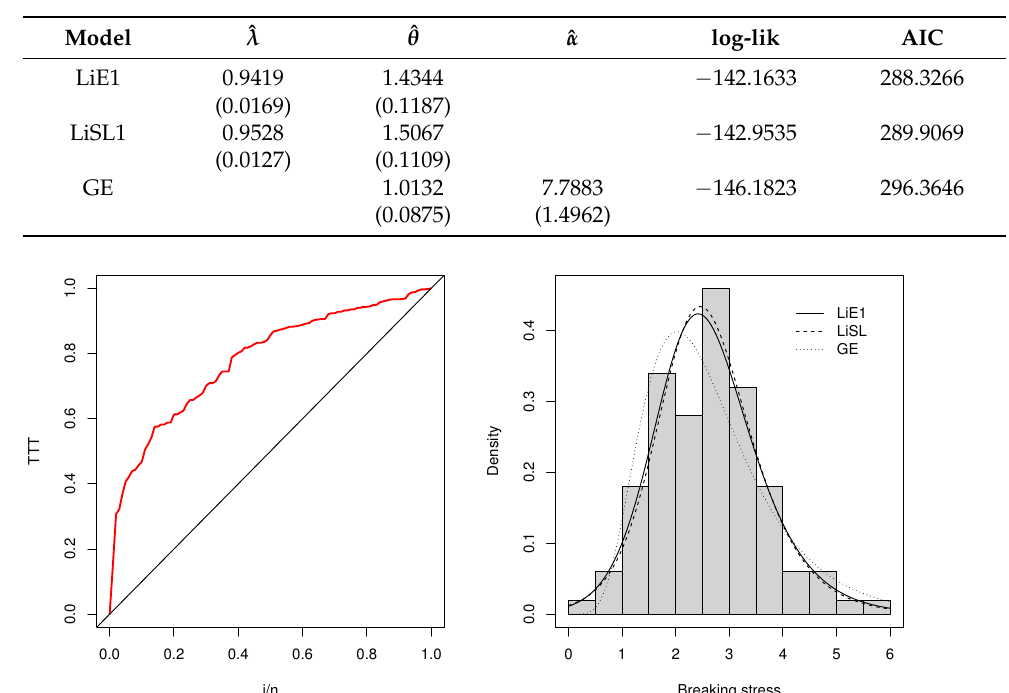
Table 4. Maximum-likelihood estimates with standard errors in parentheses, log-likelihood and AIC values for Carbon data.